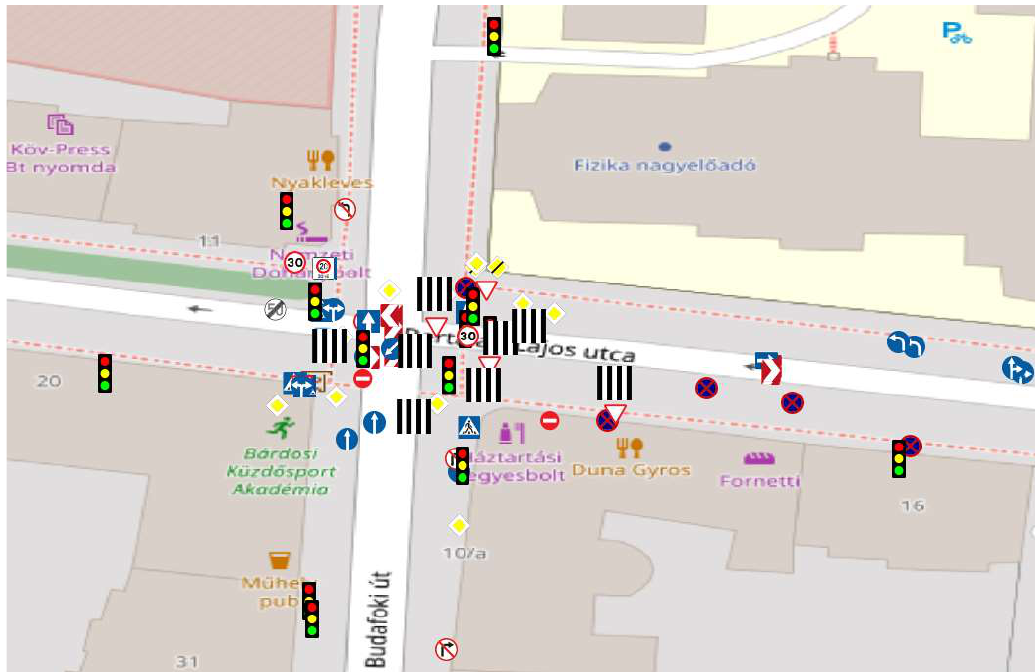
Figure 6. The smaller traffic sign test